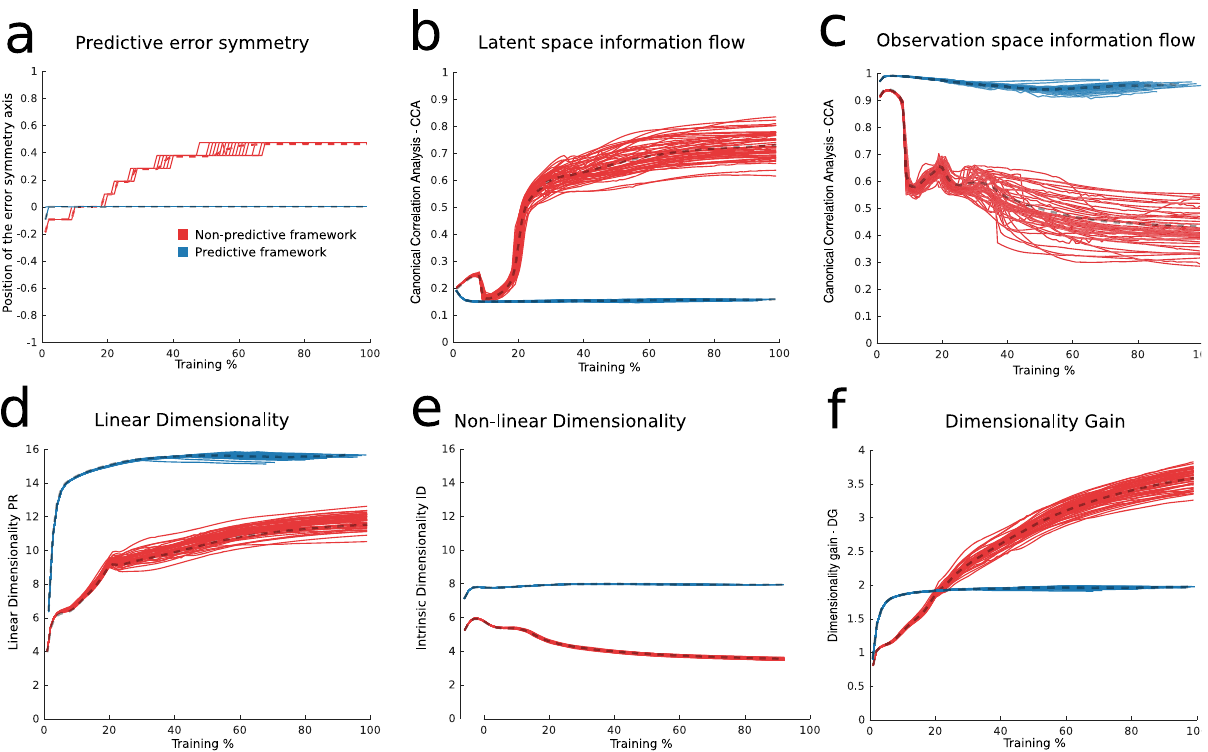
Fig. 4 Comparison between predictive and non-predictive learning. We train 50 networks of 100 neurons in each of the predictive and non-predictive conditions and equalize the learning axis between the two to highlight the trends of the different measures. a Predictive error. The position of the predictive error symmetry axis plotted throughout learning for the predictive and non-predictive network ensembles. The symmetry axis position is the one that minimizes a L2 norm between the predictive error curve (cf. Fig. 3a) and its re fl ection through the symmetry axis. b Latent signal transfer analysis. A canonical correlation analysis is performed between the latent space and the top PCs of the neural representation at every epoch, and the average of the two canonical correlations (for coordinates x and y) is shown. c Observation signal transfer analysis. The canonical correlation analysis, same as panel b , is performed between the top PCs of the observations and the top PCs of the network ’ s representation. d Linear dimensionality (PR) throughout learning. e Non-linear dimensionality (ID) throughout learning. f Dimensionality gain (DG) throughout